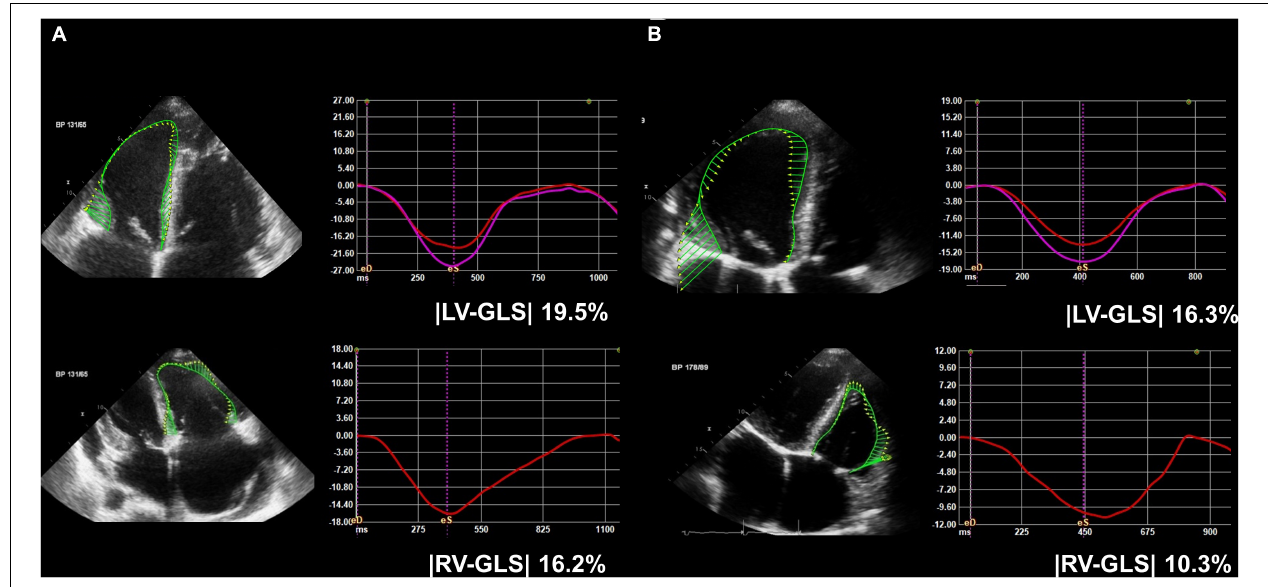
FIGURE 2 | Representative figure of (A) pre-op and (B) post-op LV-GLS and RV-GLS measurements. LV-GLS was calculated from three standard apical images, and RV-GLS was calculated from RV focused apical echocardiographic images. LV, left ventricle; RV, right ventricle; GLS, global longitudinal strain; |LV-GLS|, absolute value of LV-GLS; |RV-GLS|, absolute value of